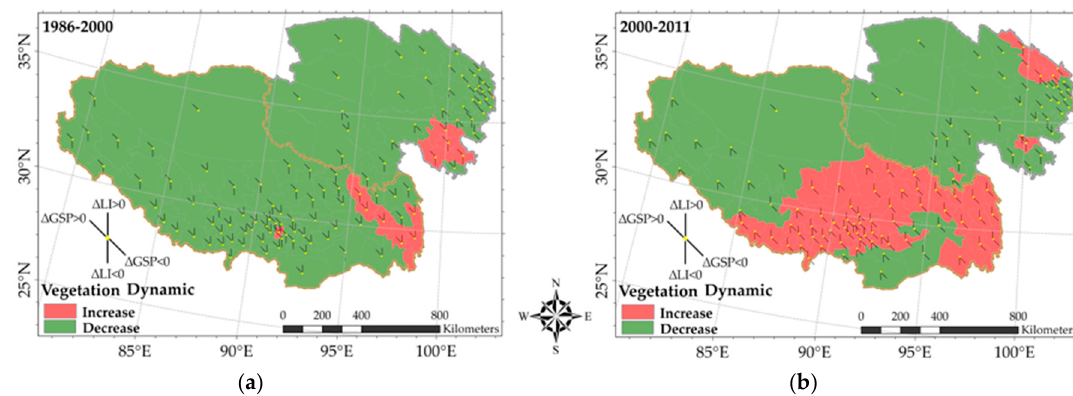
Figure 4. The change of Growing season mean precipitation (GSP), Livestock grazing intensity (LI) and vegetation vigor (based on growing season NDVI from Global Inventory Modeling and Mapping Studies Normalized Difference Vegetation Index (GIMMS3g) and Moderate Resolution Imaging Spectro-radiometer (MODIS)) over counties on the Qinghai-Tibet Plateau (Tibet and Sanjiangyuan for LI) during ( a ) the periods prior to 2000 and ( b ) the periods post 2000.